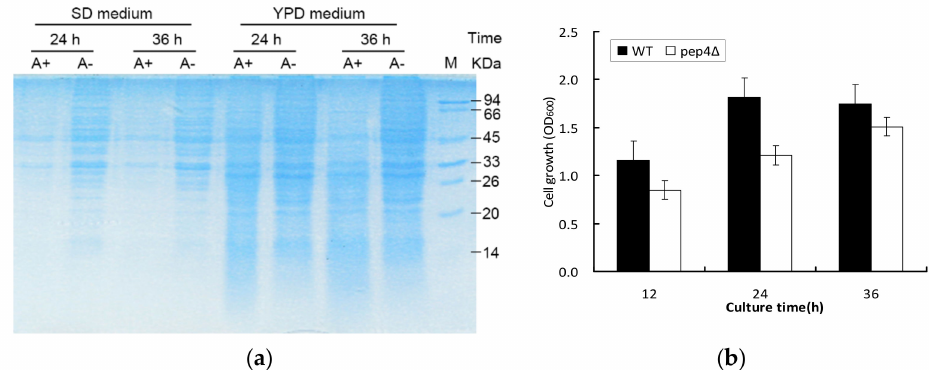
Figure 1. Cell growth and intracellular proteins expression under glucose-limited chemostat cultivation between BY4741 (A + ) and pep4 ∆ one (A − ). ( a ) SDS-PAGE showing the intracellular protein profile of BY4741 (A + ) and pep4 ∆ strain (A − ) cultured in SD and YPD medium at di ff erent culture times, respectively; ( b ) cell growth with the absorbance of 600